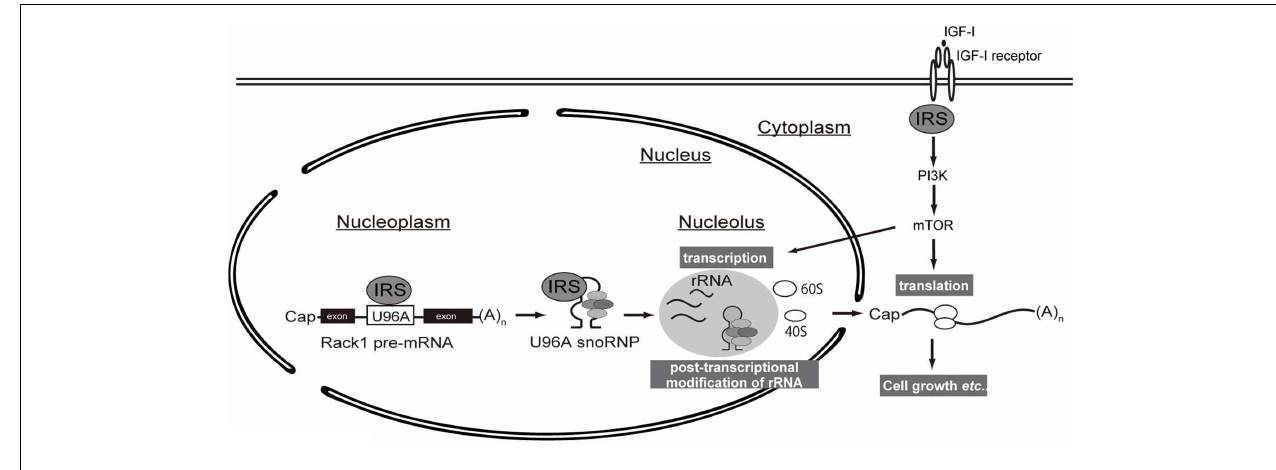
accomplished by multiple coordinated processes, including rRNA transcription and ribosome activation (e.g., ribosomal protein S6 phosphorylation).The transcribed rRNAs in nucleus undergo chemical modification by snoRNP complexes whose biogenesis is controlled by nuclear